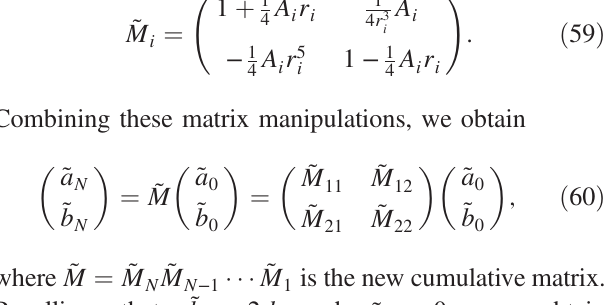
ξ . The results shown here